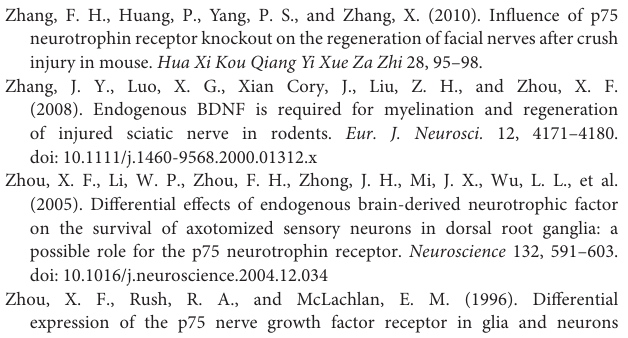
Conflict of Interest Statement: The authors declare that the research was conducted in the absence of any commercial or financial relationships that could be construed as a potential conflict of